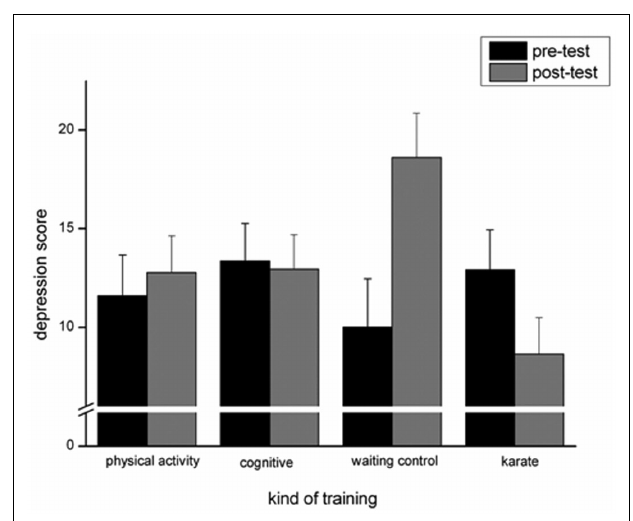
FIGURE 1 | Depression score in the pre- and post-test dependent for each of the trainings groups.